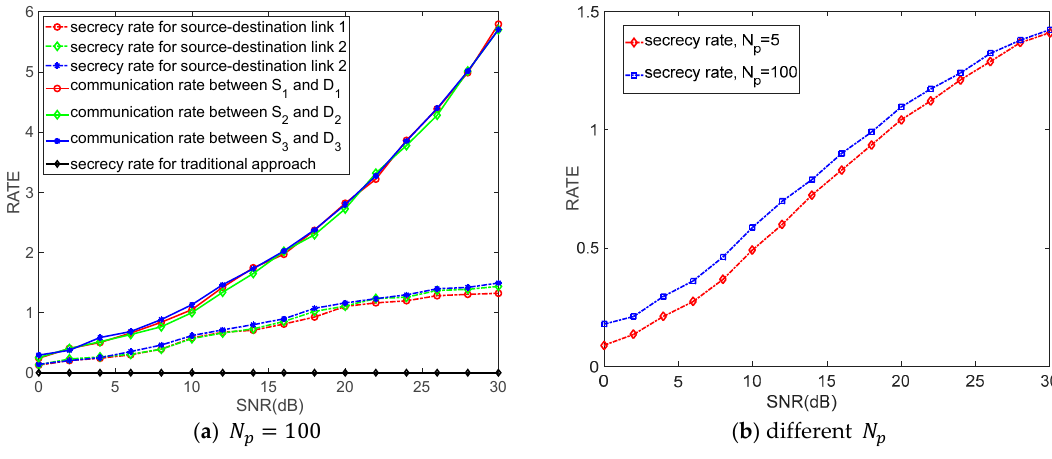
Figure 4. The communication rate and secrecy rate versus SNR.